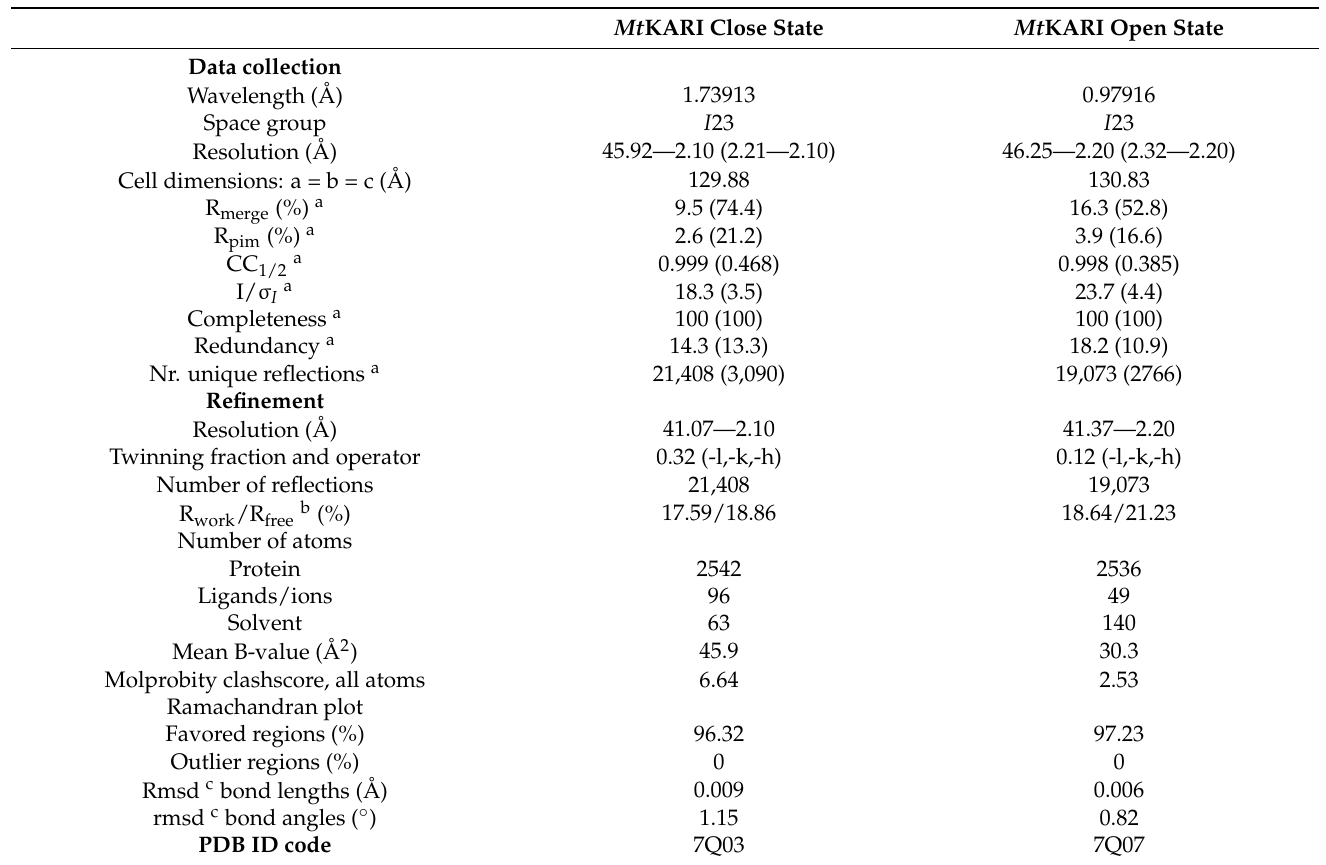
Table 1. X-ray crystallographic data and refinement